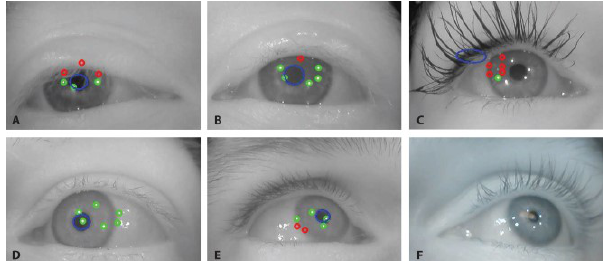
Figure 18. Examples of challenging issues. Green dots in- dicate identified glints, red dots indicate glints inferred as non-visible (at locations where the posterior glint model expects them), blue circle depicts the located pupil ellipse. (A,B) simultaneous frames for the left and right eyes, where the eyelid and eyelashes occlude some of the glints and part of the pupil. (C) Heavy mascara corrupt- ing the pupil location and “draggi ng" the glint grid to the left. (D) additional false reflections on the scleral surface.